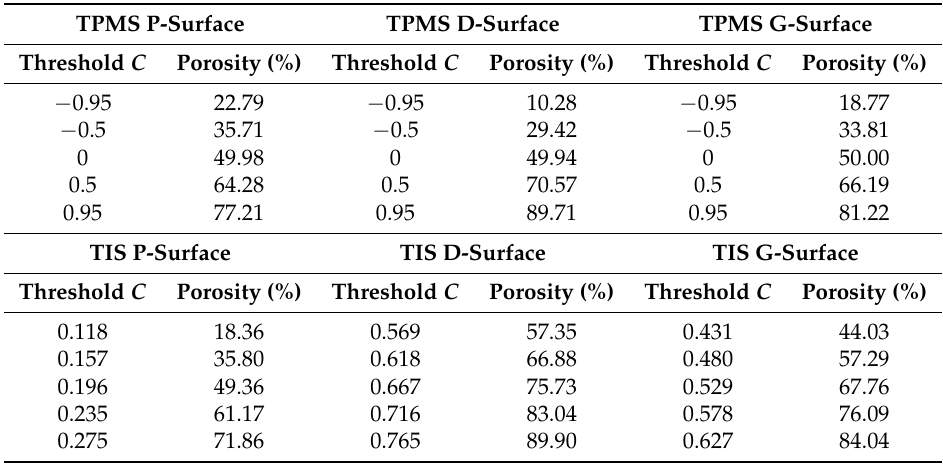
Table 3. Effect of diverse thresholds C on different TPMS and TIS